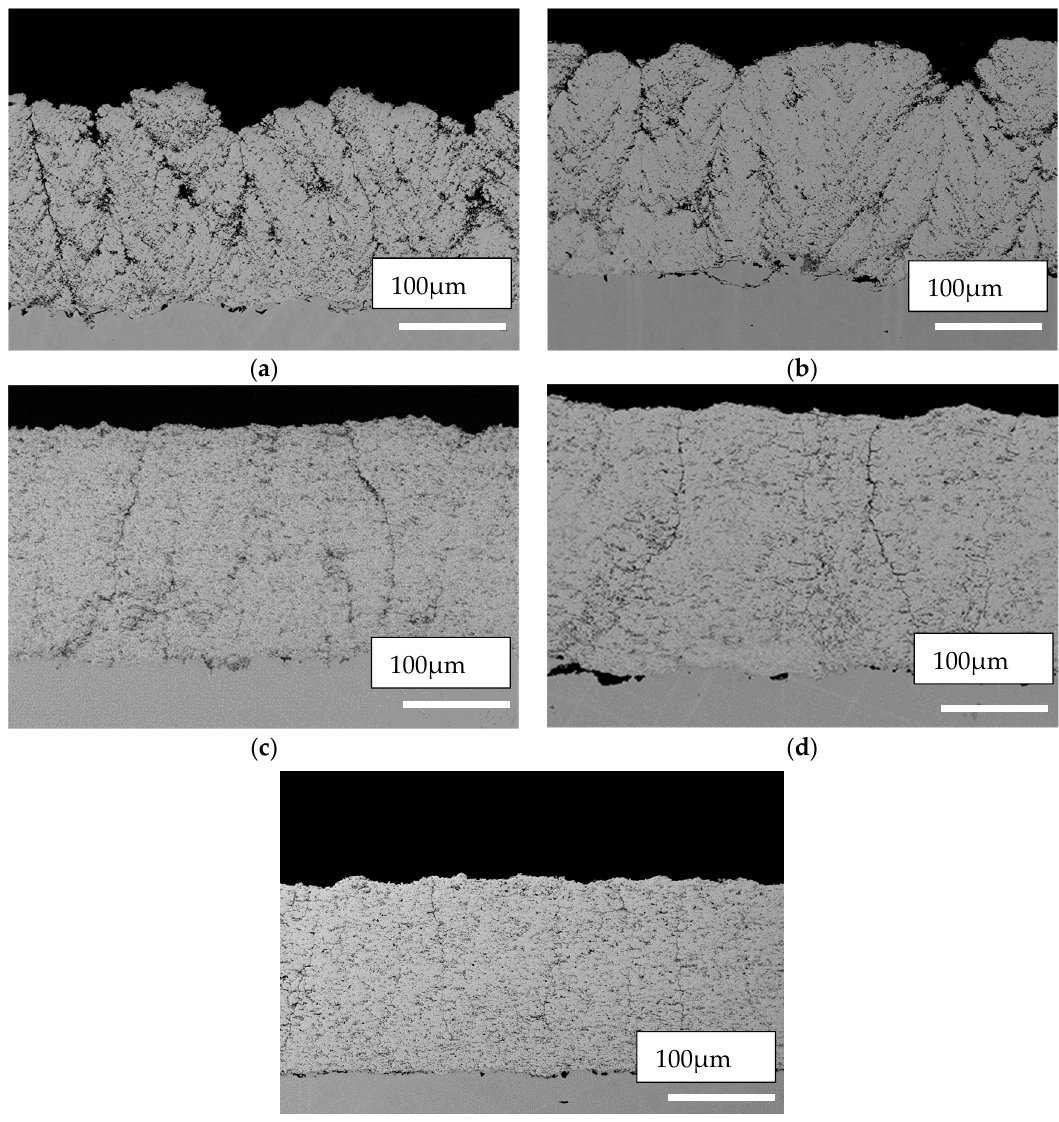
Figure 8. Backscattered SEM micrographs of the coatings deposited by radial injection using various suspensions; ( a ) C1, ( b ) C2, ( c ) HM2, ( d ) HM1, and ( e ) C3. suspensions; ( a ) C1, ( b ) C2, ( c ) HM2, ( d ) HM1, and ( e )